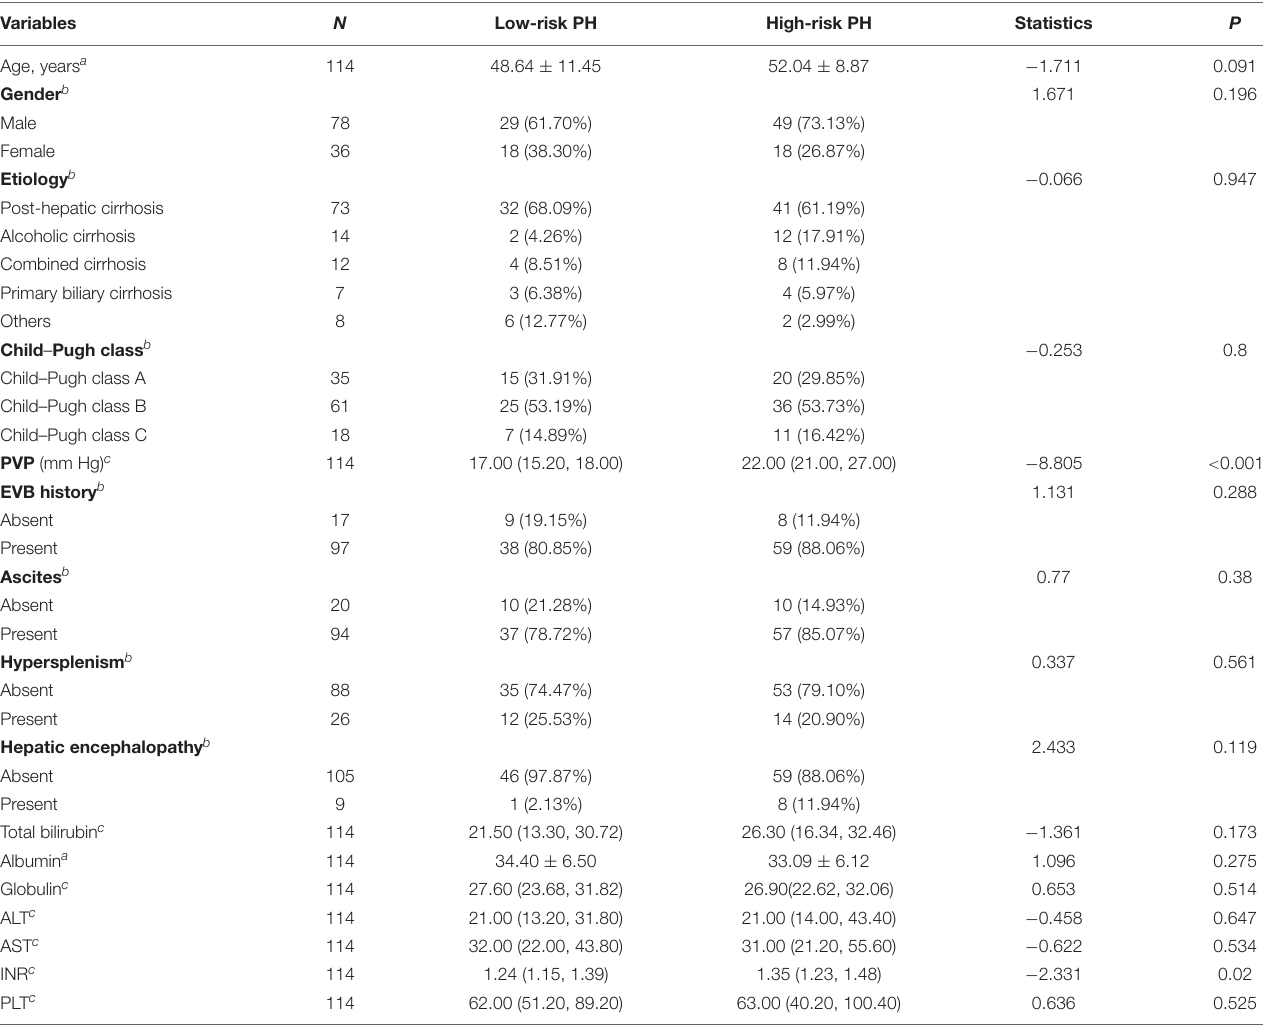
TABLE 1 | Demographics and clinical characteristics of the study population.